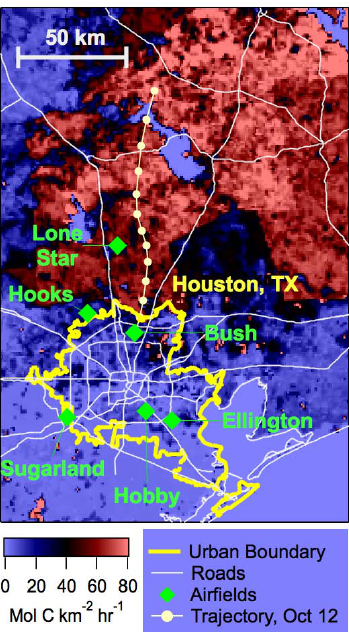
Fig. 1. Map of the Houston, TX, area showing the location of air- fields, major roadways (white lines) and monoterpene emission po- tential (blue-red color scale, legend below) from the BEIS3 inven- tory. The line with circles is a twelve-hour forward trajectory from Bush airfield on the north side of Houston, beginning at sunset on 12 October (see